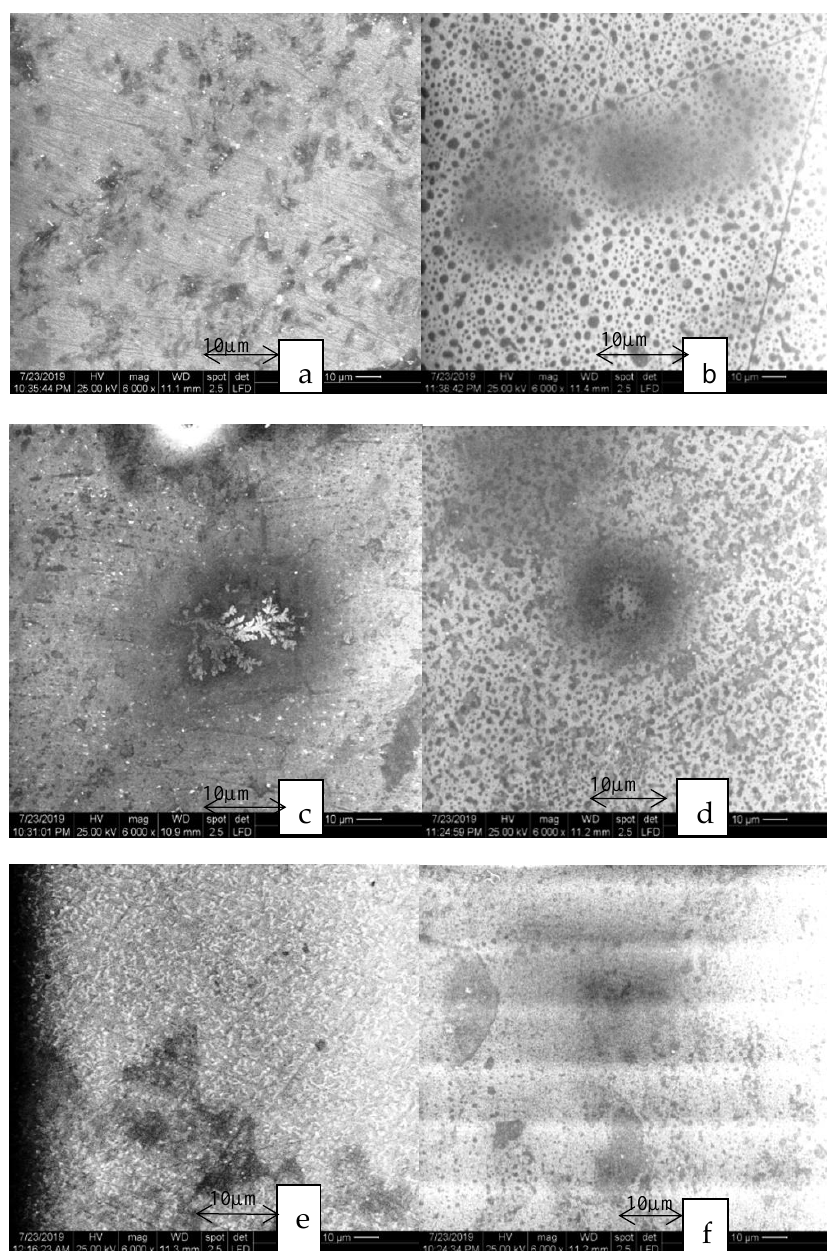
Figure 6. SEM images of the milled samples before thermocycling. ( a ) FMP samples; ( b ) FMG samples; ( c ) LDMP samples; ( d ) LDMG samples; ( e ) ZLSMP samples; ( f ) ZLSMG samples.